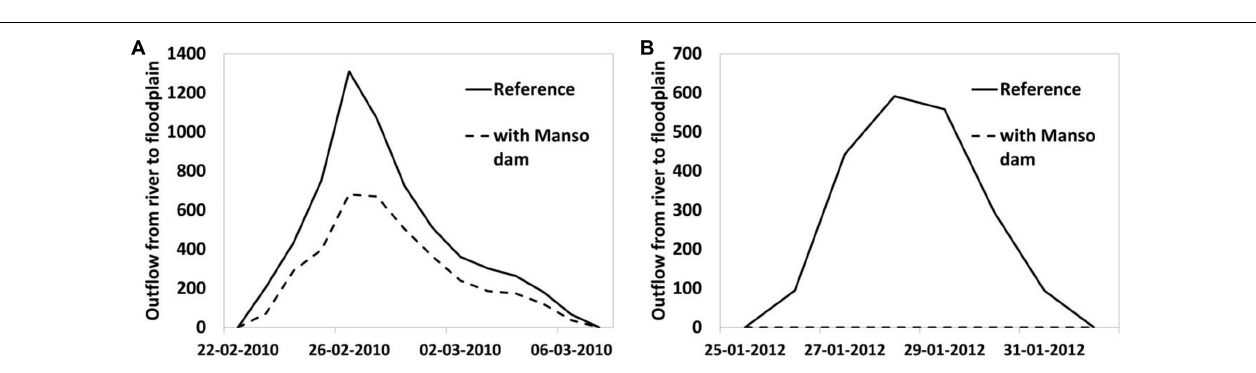
by the dam operation. Average peak outflows during the years 2003 to 2015 are 64% lower in the altered